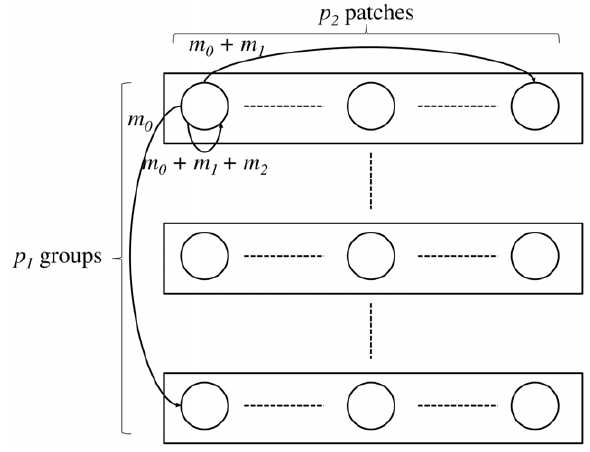
Figure 1. Hierarchical environment structure. P ~ p 1 | p 2 patches are distributed among p 1 groups of p 2 patches. m 0 : dispersal rate between patches that belong to different groups, m 0 z m 1 : dispersal rate between patches that belong to the same group, m 0 z m 1 z m 2 : intra-patch dispersal rate.